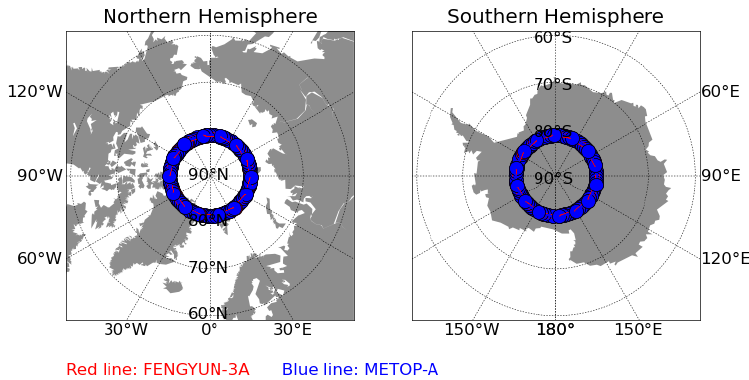
Figure 3. Spatial distributions of cross points between FY-3A and METOP-A nadir tracks in one day. The difference in overpass time is within 10 min.